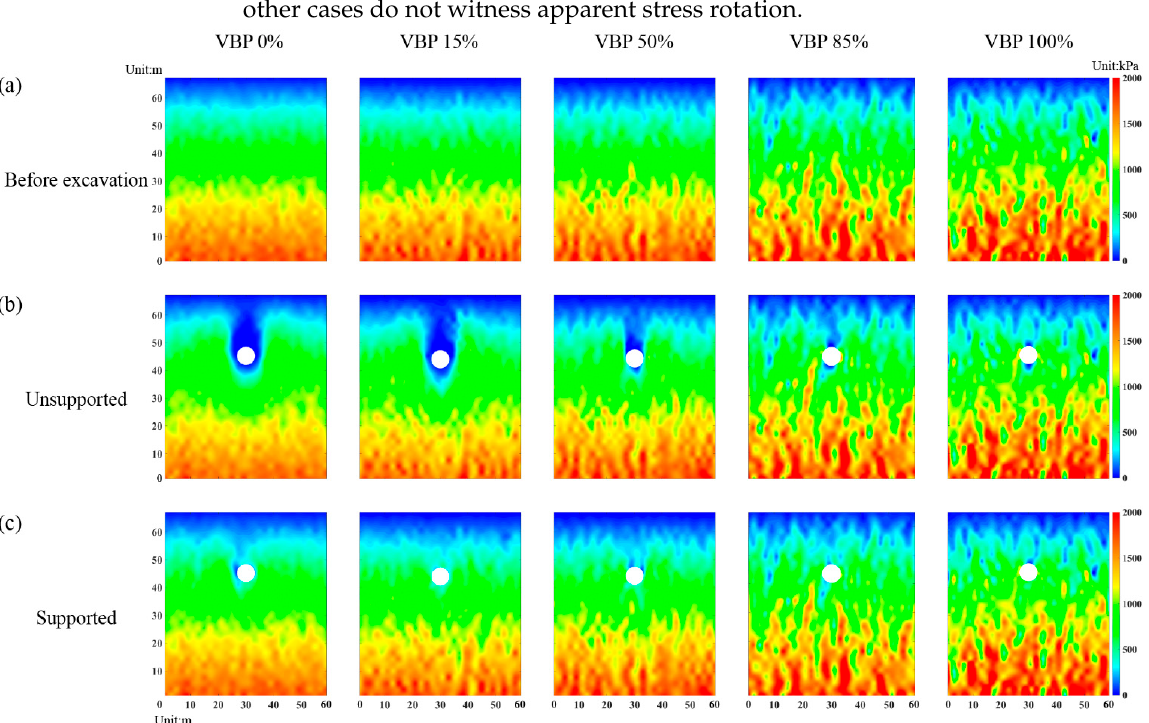
Figure 12. The distribution of horizontal stresses in the computational domain: ( a ) initial state before excavation, ( b ) unsupported tunnel excavation, and ( c ) supported tunnel excavation by rigid lining.